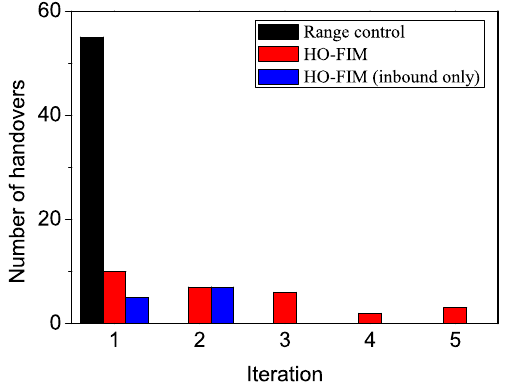
Figure 11. Number of handovers over iterations ( M = 30, F =